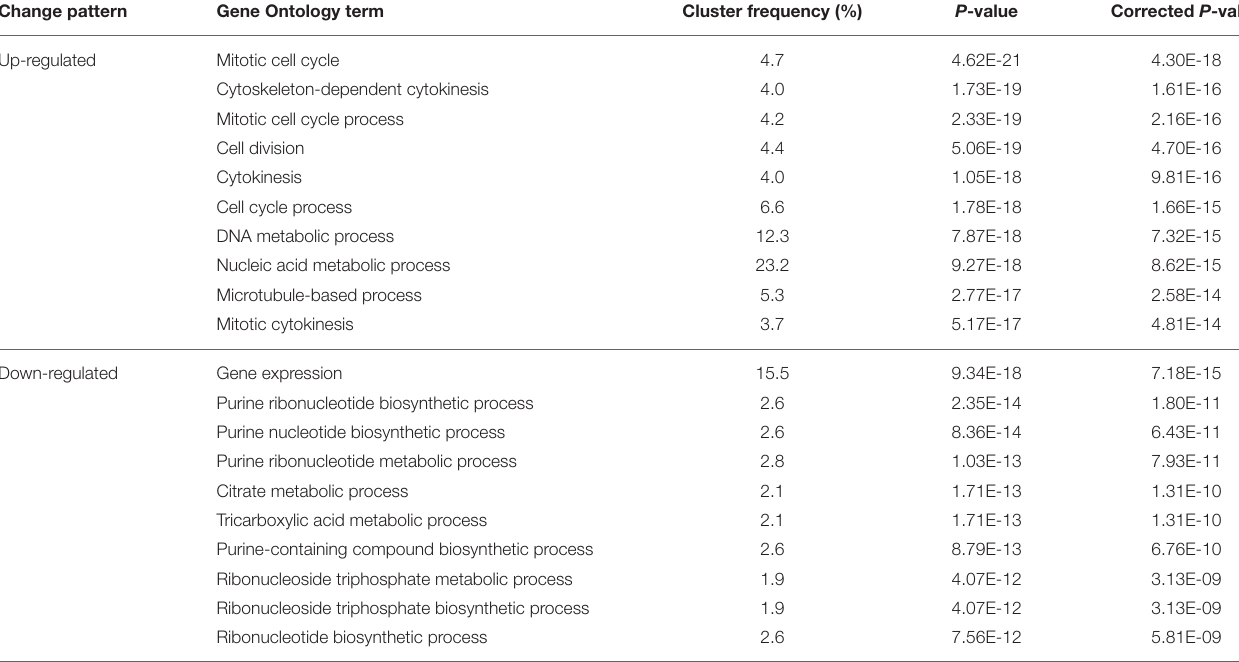
Top 10 most significant processes are